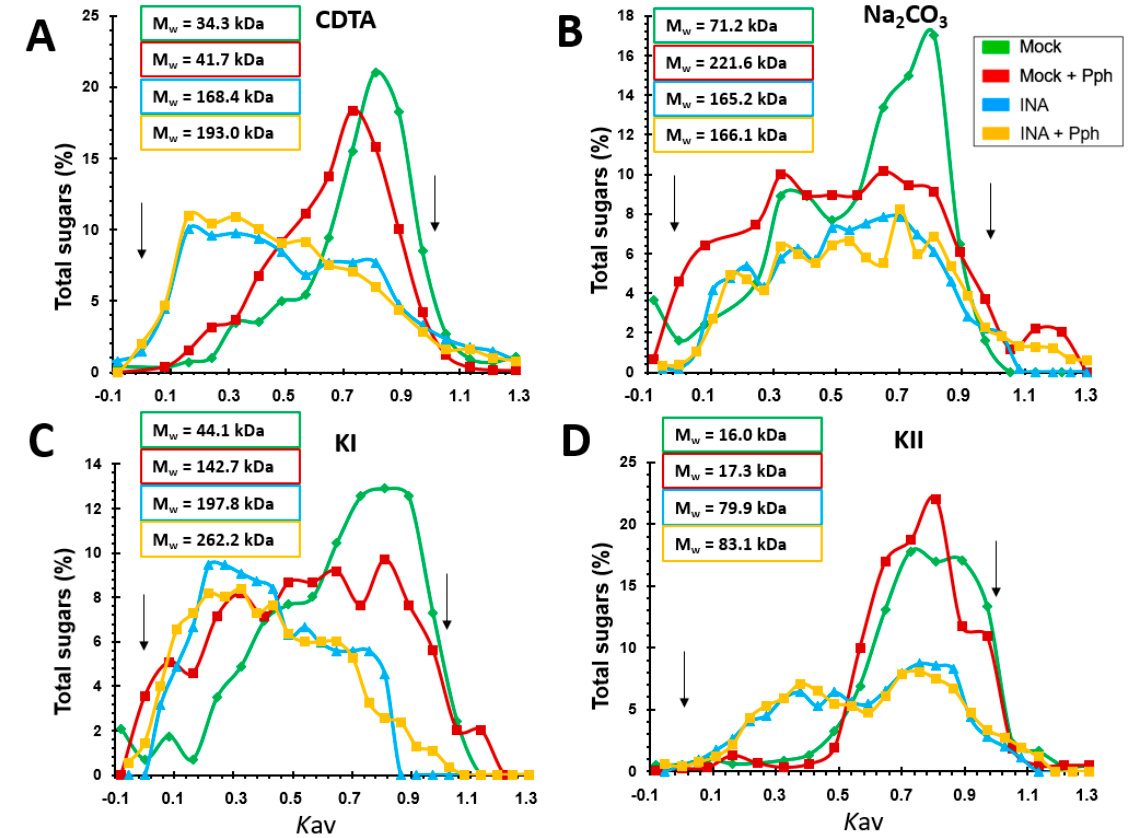
Figure 7. Relative mass distribution profiles of CDTA ( A ), Na 2 CO 3 ( B ), KI ( C ), and KII ( D ) fractions extracted from CWs of Mock, Mock + Pph, INA and INA + Pph. 0 and 1 K av were assigned to blue dextran and sucrose markers, respectively (indicated with arrows). The average molecular weight in kDa (M w ) obtained by K av(1/2) method is shown inserted in boxes.